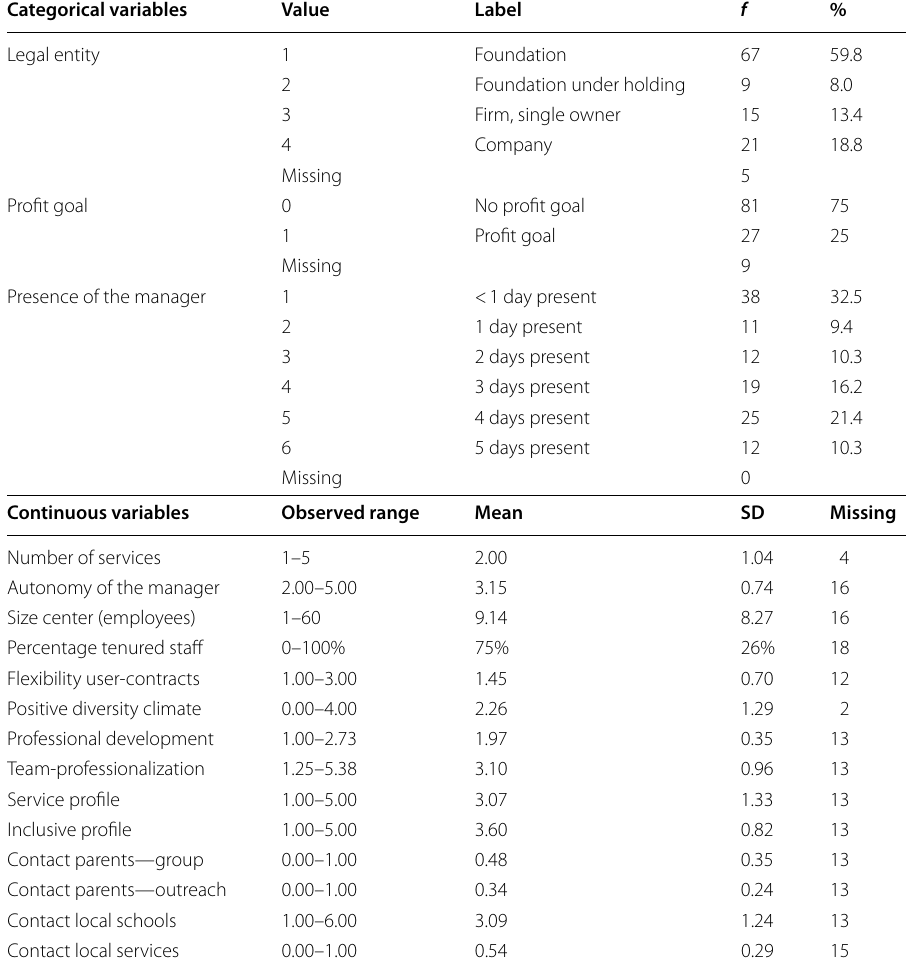
Table 1 Descriptive statistics of the organizational characteristics (managers’ reports; N 117) = Categorical